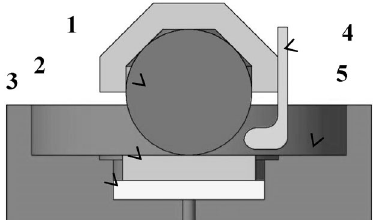
Fig. 1 Sketch of the electrically insulated test setup with ball- on-disk geometry. 1. Reciprocating SiC ball; Galvanic cell due to different material combinations: 2. Upper stainless steel disk (1RK91in contact with SiC ball); 3. Used materials for lower disk: copper (Cu), aluminium (Al), and teflon (PTFE); 4. Ag/AgCl- reference electrode to measure the induced electrochemical potential; 5. Electrolyte reservoir filled with lubricant (1 molar sodium chloride (NaCl) and 1% imidazolium-based ionic liquid [C 2